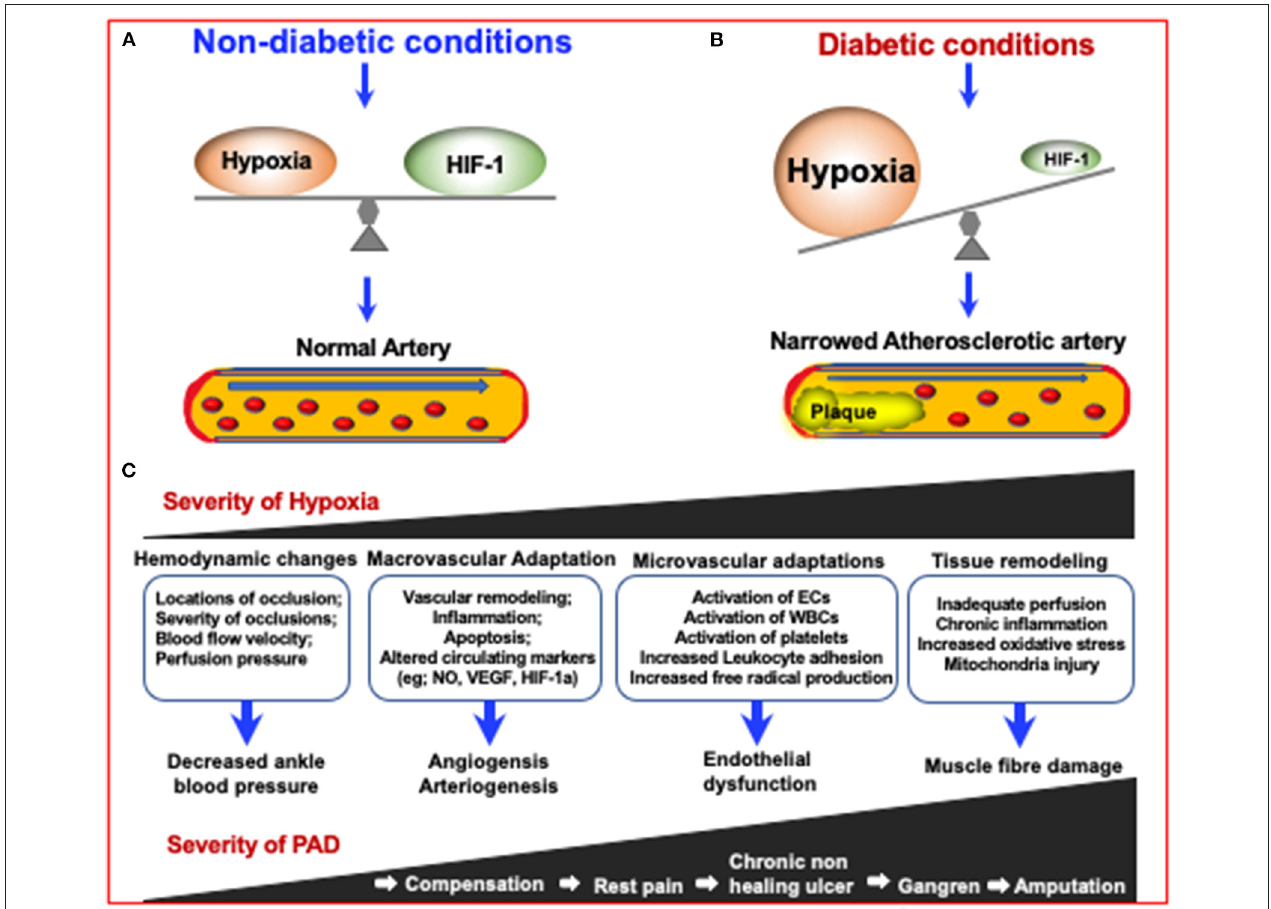
FIGURE 3 | The mechanisms in which diabetes can increase the severity of Peripheral Artery Disease (PAD) via increasing the severity of hypoxia which results in narrowing of arteries. Due to the inhibition of HIF-1 in diabetes, an impaired response to hypoxia can lead to diabetes and diabetic complications. (A) Under non-diabetic conditions, HIF-1 signaling responds to reduced oxygen levels, resulting in a steady state of hypoxia. (B) In the case of diabetes, although the tissue is more hypoxic, HIF-1 signal transduction is inhibited, resulting in impaired adaptive response to hypoxia, leading to the development of diabetes and its complications ( 155). (C) The consequences of increased PAD severity and hypoxia severity are highlighted in the boxes and describe the consequences respective to the degree of PAD